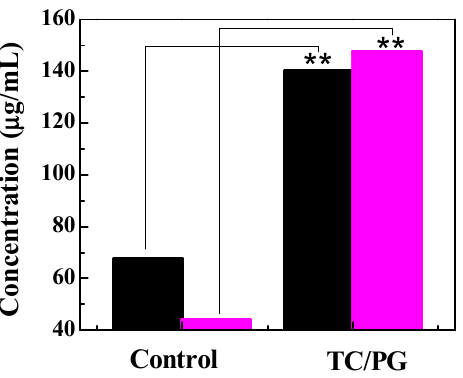
Figure 7. The protein leakage concentration in E. coli (black column) and S. aureus (pink column) suspensions treated with TC/PG